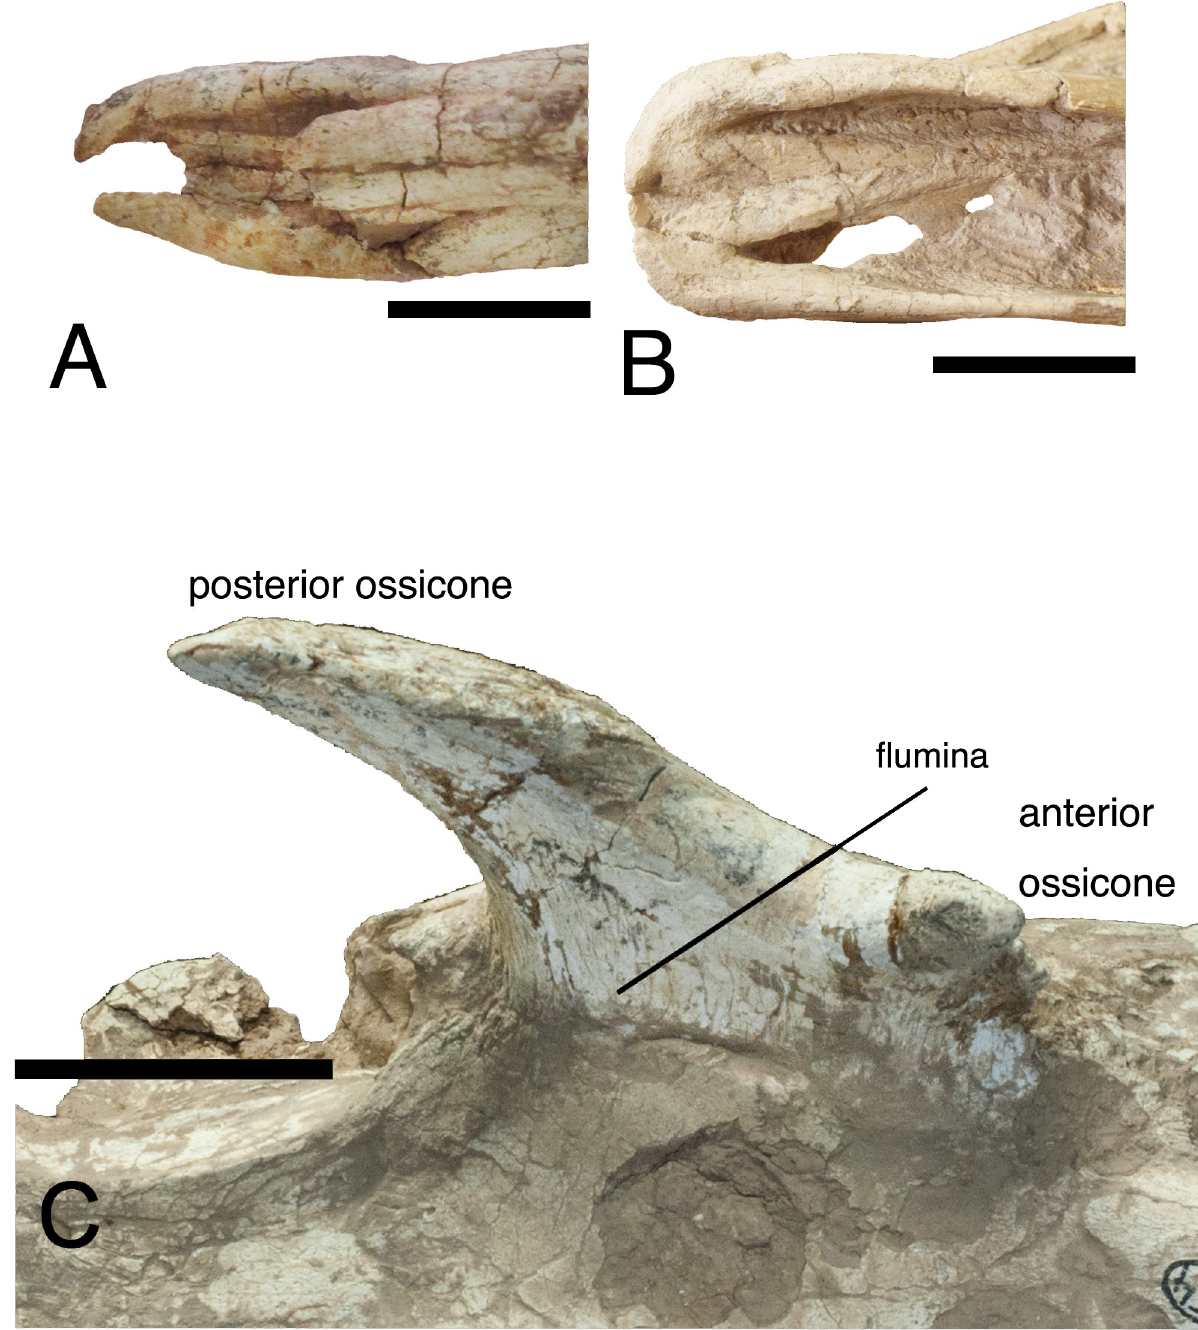
Fig 9. Premaxillae and ossicone. (A) Premaxilla HMV 1416, Schansitherium tafeli from Gansu. (B) Premaxilla Samotherium boissieri from Samos NHMUK 1415. (C) Schansitherium tafeli HMV 1931 left ossicone. Scale 50mm. apex. We find this to be widespread among Giraffidae, and we give it the new term para-apex (Fig 14). This is the location where palaeomerycid ossicone bends abruptly, which is why it is deserving of its own term [27]. On the streaks in some specimens there are overgrown protru- sions with lumpy appearances. The secondary bone growth appears to have formed on the